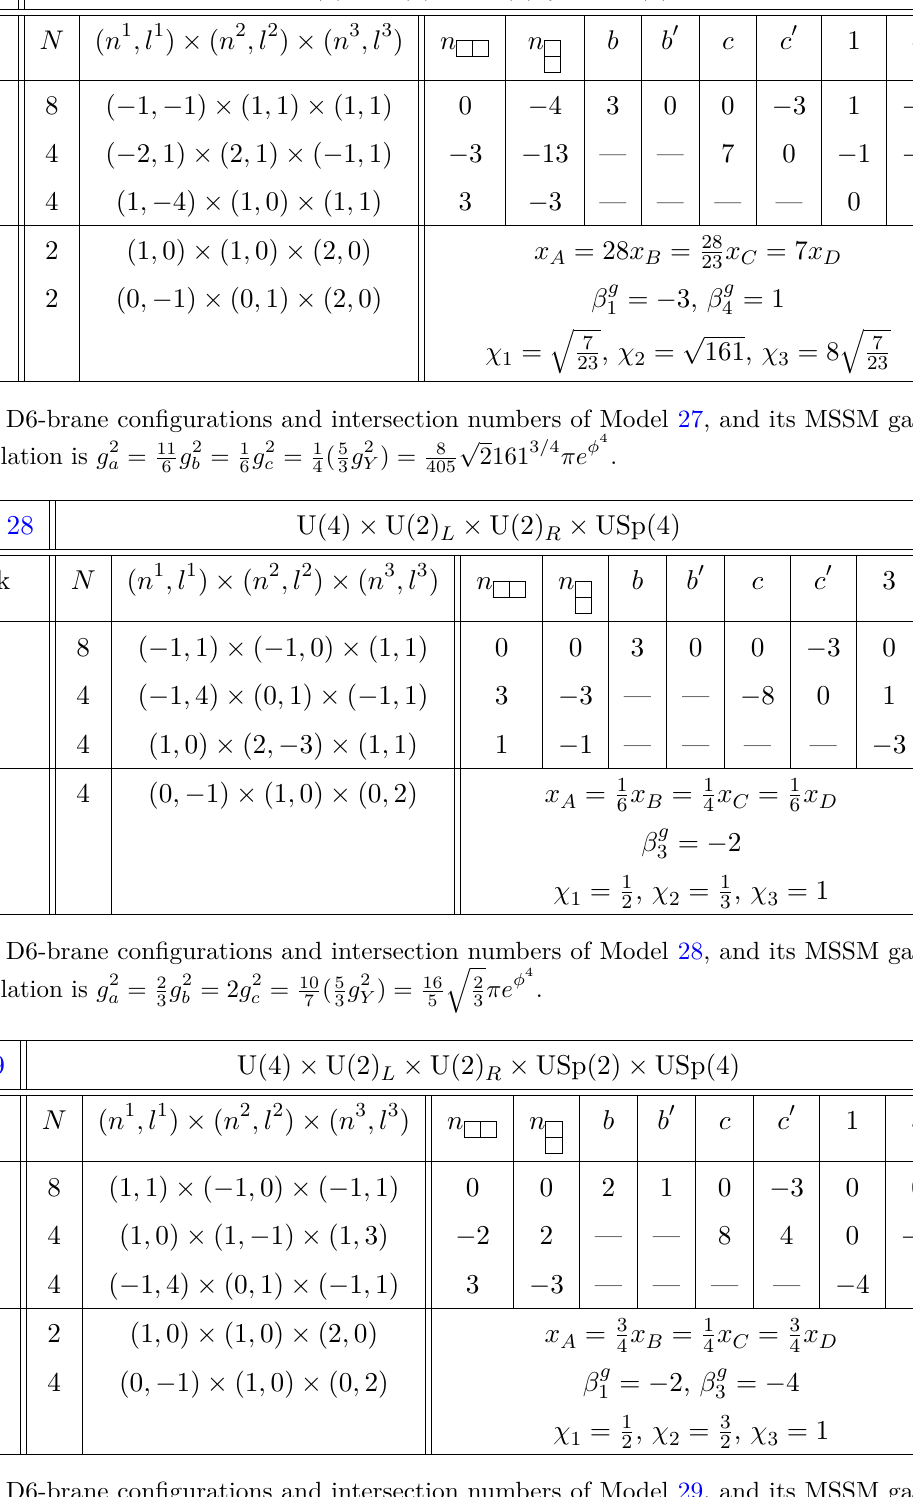
Table 29 . D6-brane configurations and intersection numbers of Model 29, and its MSSM